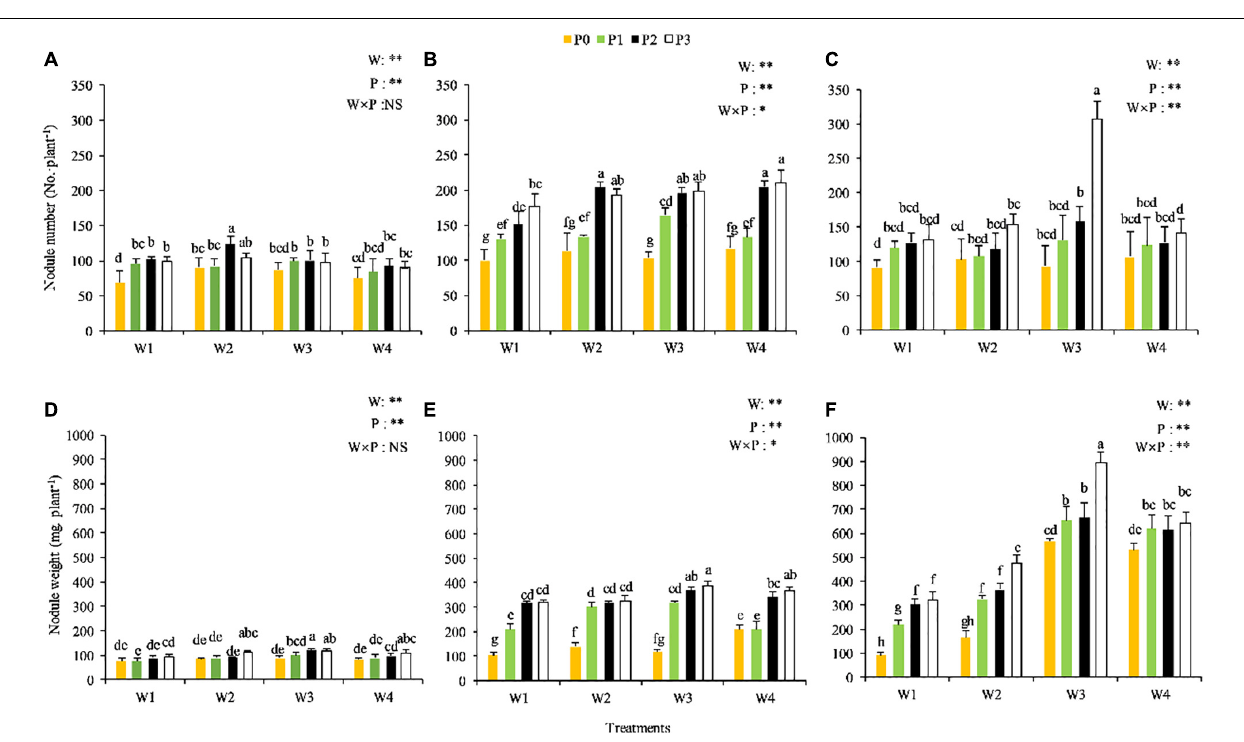
FIGURE 3 | Number and weight of nodules of the CMV at the different soil moisture contents and levels of added phosphorus. (A,D) Represent the seedling stage, (B,E) represent branching stage, and (C,F) indicate as full-flowering